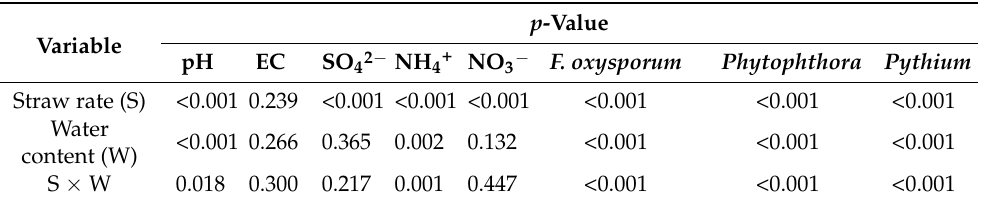
Figure 1. The effects of water content and maize amendment rate on soil EC and pH after RSD treatment. Error bars indicate standard deviations. Different uppercase letters in EC implicate the a significant difference among the same maize straw amended rate under different soil water contents, and lowercase letters within the same water content show significant differences among the various maize straw amended rates (SNK tests, p < 0.05). Different lowercase letters show a significant difference among the various treatment of pH (SNK tests, p < 0.05). The dashed lines represent the initial value of the original soil. Table 3. ANOVA analyses of the RSD effects of maize application rates and soil water contents on soil properties and populations of soil-borne